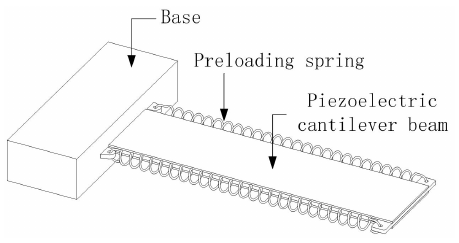
Figure 1. Schematic diagram of a preloaded piezoelectric actuator.